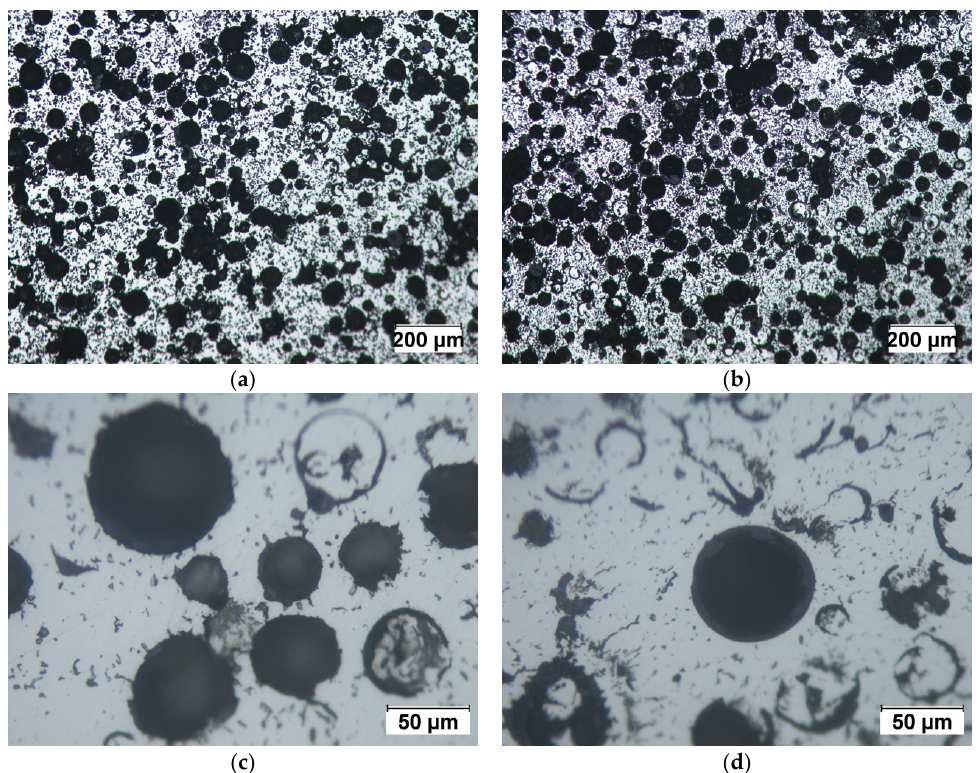
Figure 3. Optical micrographs of ( a , c ) Invar ‐ 5CS; and ( b , d ) Invar ‐ 10CS at different magnifications.